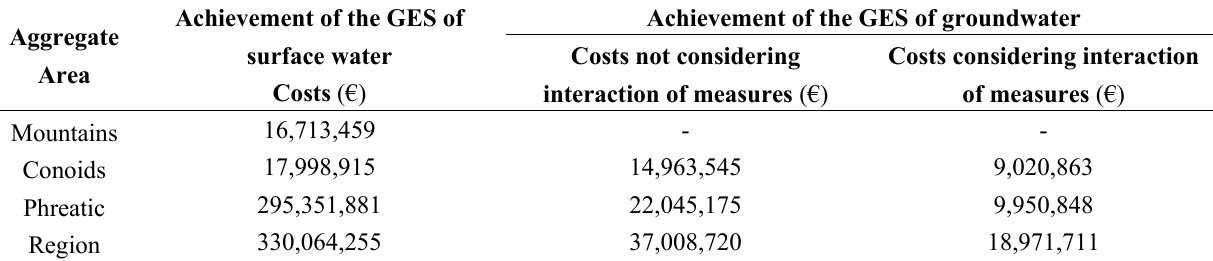
Table 5. Cost estimation at the level of aggregation of groundwater bodies. For groundwater, costs estimated when taking into account interactions between measures are also provided. GES, Good Ecological Status.